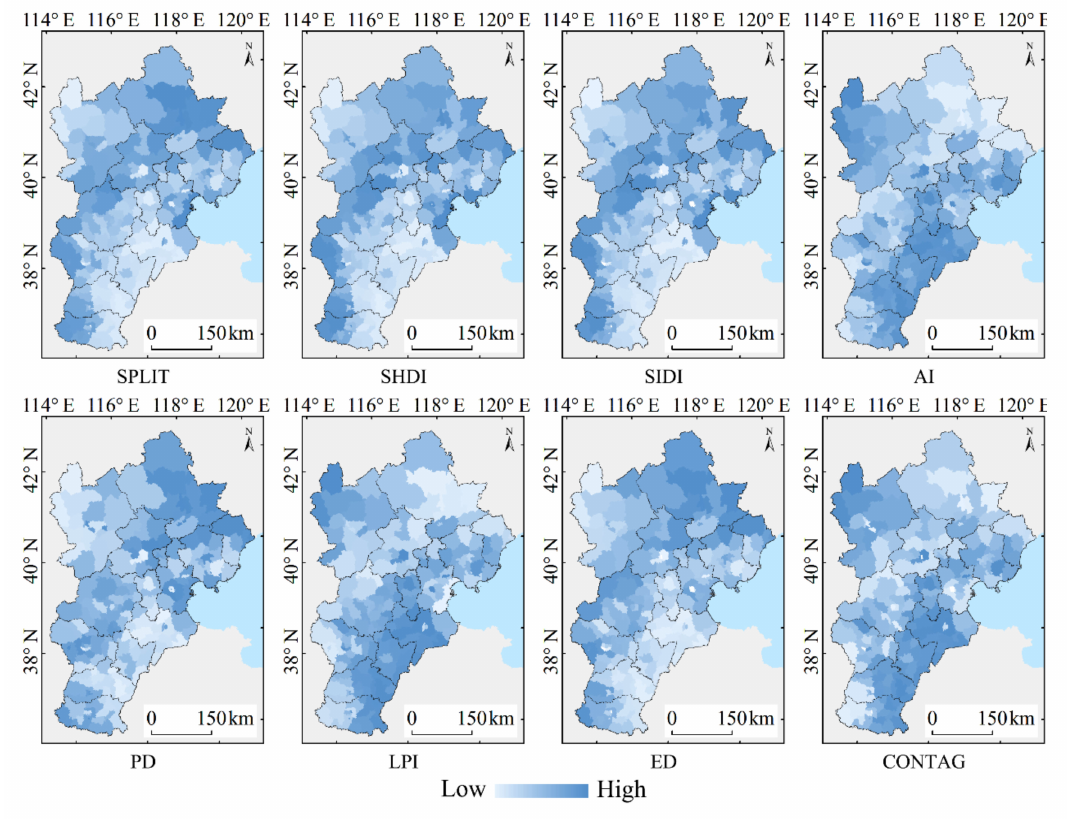
Figure 9. Spatial distributions of the landscape pattern indices at the landscape level. Table 6. Correlations between the particle concentrations and indices at the landscape level. PM 2.5 PM